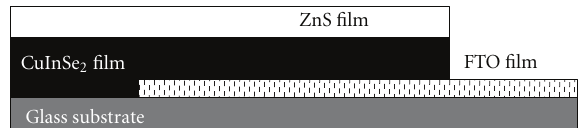
Figure 2: Cross-section of prepared samples with ZnS and CuInSe 2 films. Table 1: Particle size of CuInS